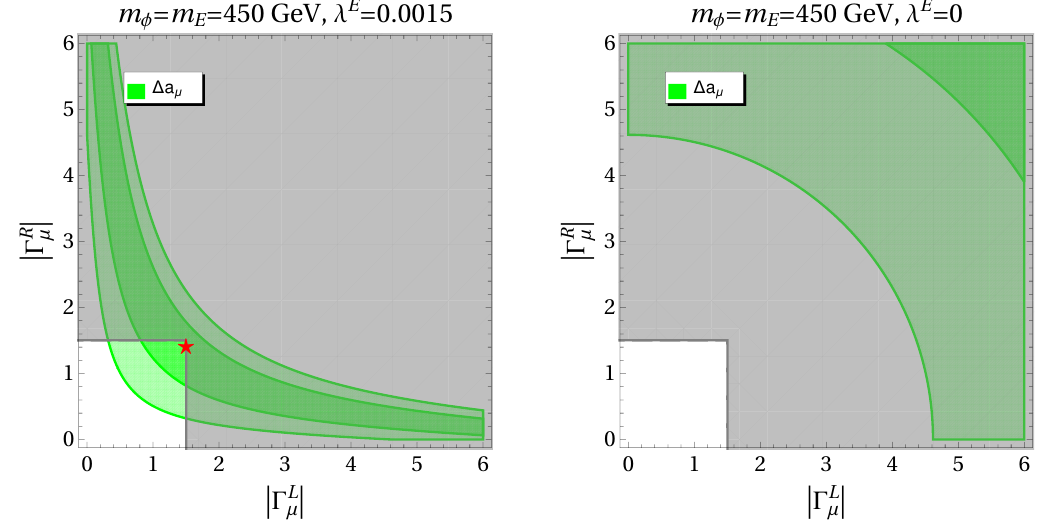
j from the muon (cid:22) j , assuming m (cid:30) = 450 GeV, x E =1 and (cid:21) E = (cid:22) j is given in gray. (cid:22)